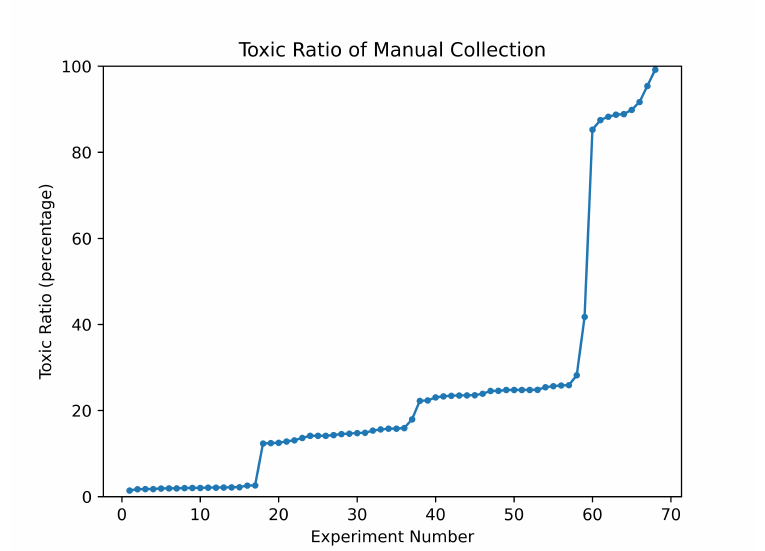
Figure 11. Manual method packets toxic ratio in